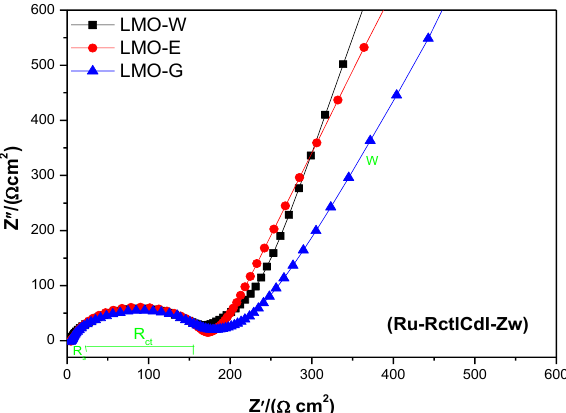
Figure 7. Electrochemical impedance spectra of the samples after 100 cycles of CC testing over a frequency range of 1 MHz to 10 MHz with a cut-off voltage of 3.0 V. frequency range of 1 MHz to 10 MHz with a cut-off voltage of 3.0